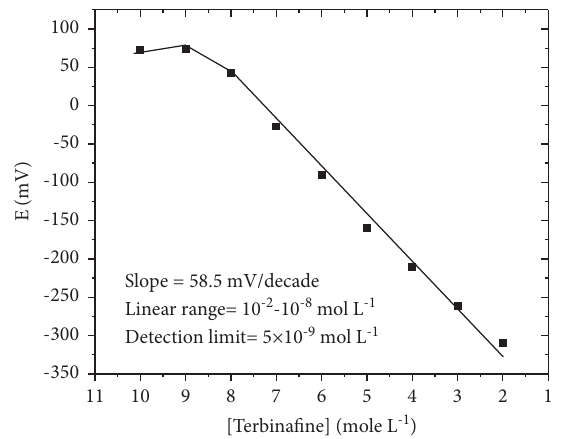
Figure 4: Potentiometric calibration response of the terbinafne screen-printed microchip.